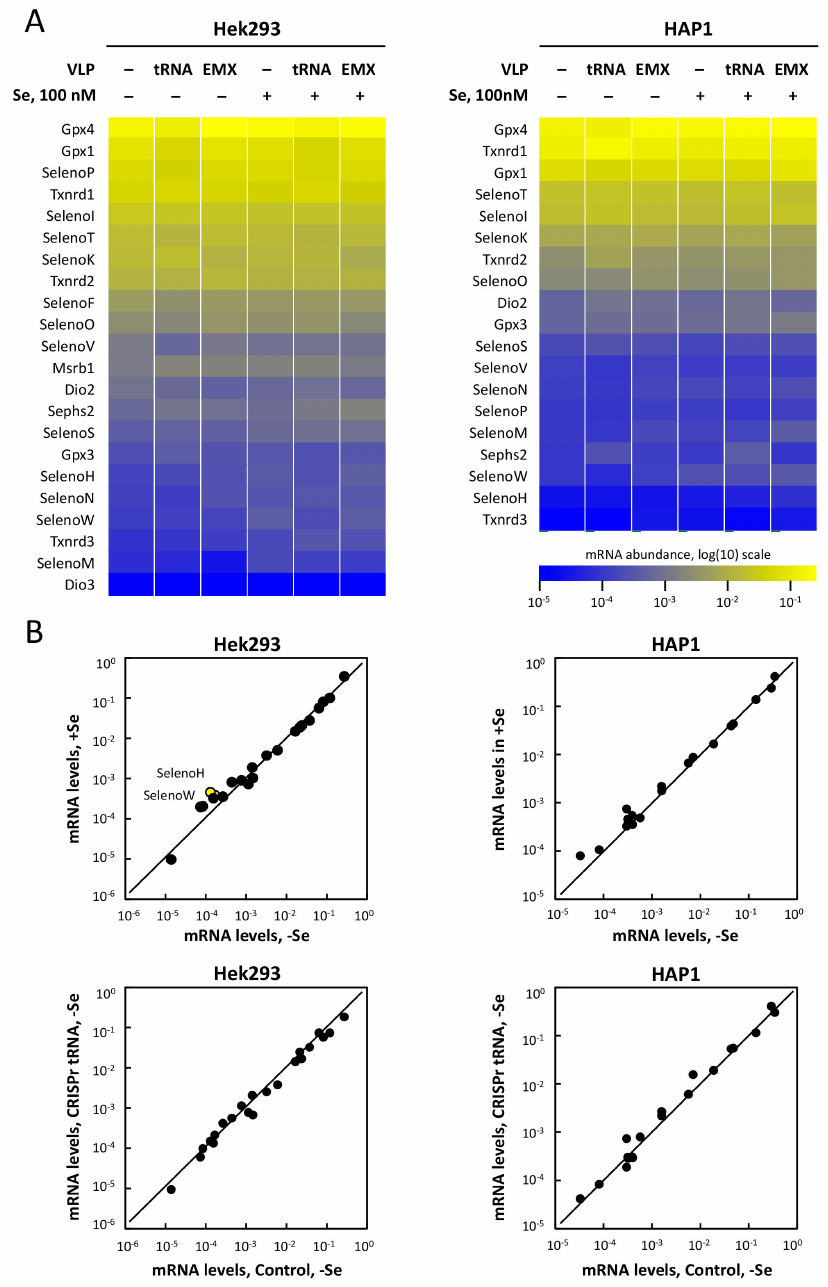
Figure 8. Evolution of selenoprotein mRNA levels in response to the CRISPR-Cas9-VLP treatments and / or addition of selenium (100 nM) in Hek293 and HAP1 cell lines. ( A ) The RNA extracts used in Figure 6 were also used for RT-qPCR analysis to measure selenoprotein and housekeeping mRNA levels. The geometrical mean of five housekeeping genes (Hpcb, Rps13, rRNA 18S, Hrpt, and Gapdh) was used to normalize mRNA abundance. Selenoprotein mRNA levels are represented in logarithmic scale in a heatmap. The values are given in Table S2 and Table S3. ( B ) To validate the stability of steady state levels of selenoprotein mRNAs, the values obtained in control conditions (no VLP, no added Se) were plotted as a function of values obtained with 100 nM Se (top histograms) or with tRNA VLP treated conditions (bottom histograms) in a logarithmic scale. For clarity reasons, only mRNAs for which a minimum of two-fold di ff erence (and p-value below 0.05) were represented in yellow circle and labeled in the